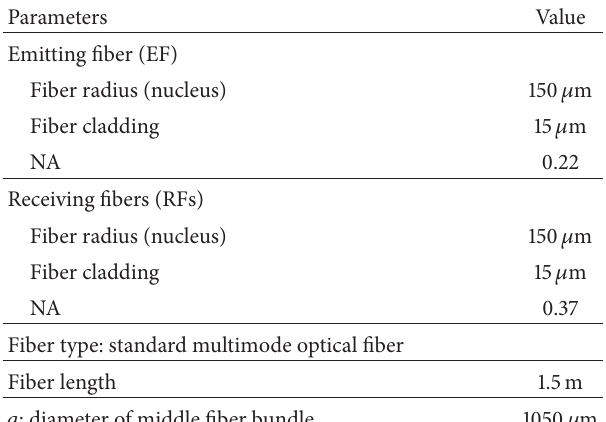
Table 1: Design parameters of the sensor fiber